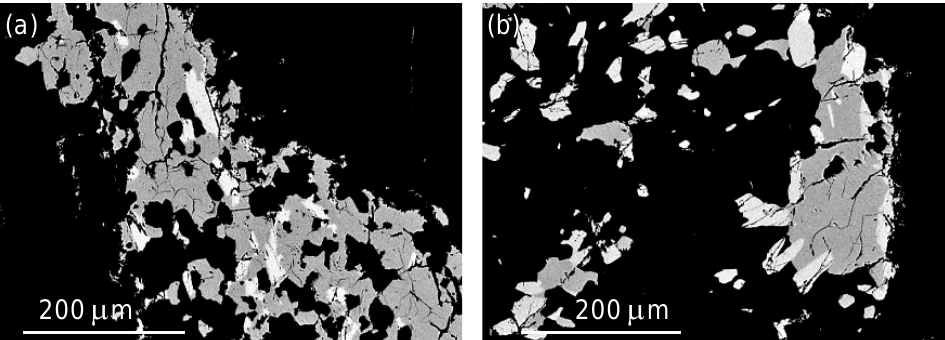
Figure 5. ( a ) The elongated grains of Cu-bearing robinsonite (white) and bournonite aggregates (grey) in tetrahedrite (black); ( b ) tintinaite grains (white) and bournonite aggregates (grey) in tetrahedrite (black). BSE photos.